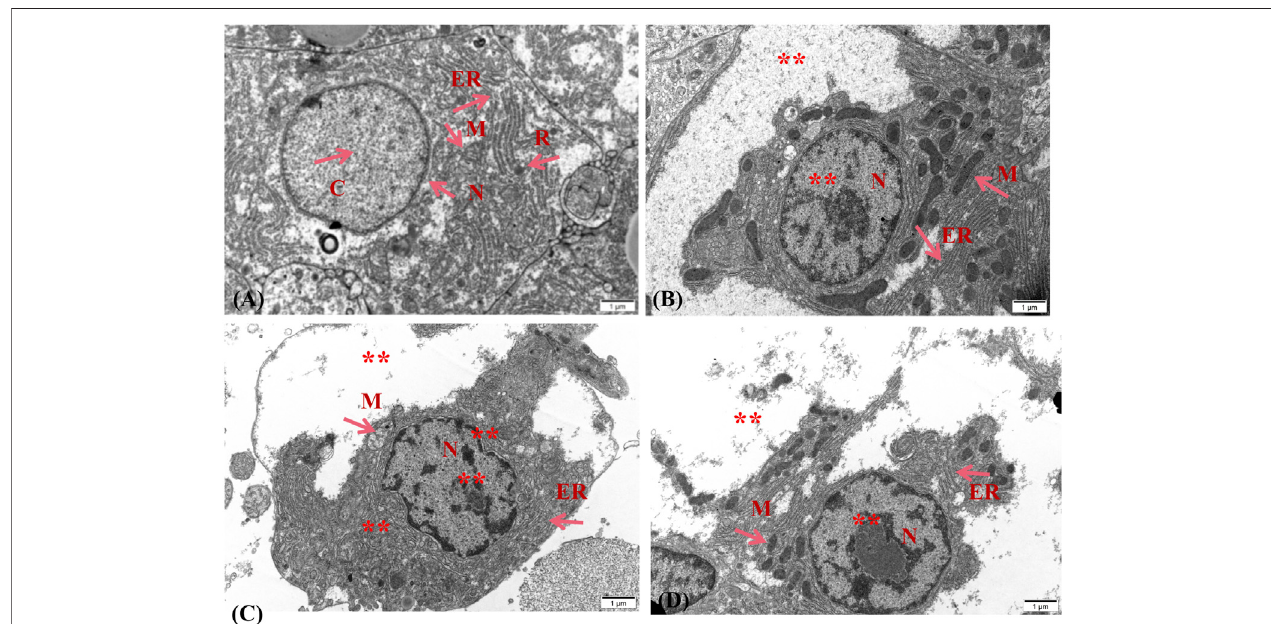
FIGURE8| Effectof4,4 ′ -di-CDEontheultrastructureofzebra fi shliverafter14 daysofexposure.Theultrastructure ofzebra fi shliverexposedto (A) controlgroup, (B) 1 μ g/L, (C) 10 μ g/L, and (D) 50 μ g/L 4,4 ′ -di-CDE, and photomicrographs were taken using ×15000 magni fi cation. N, nucleus; C, chromatin; M, mitochondria; ER, endoplasmic reticulum; R, ribosome; **, large area damage.